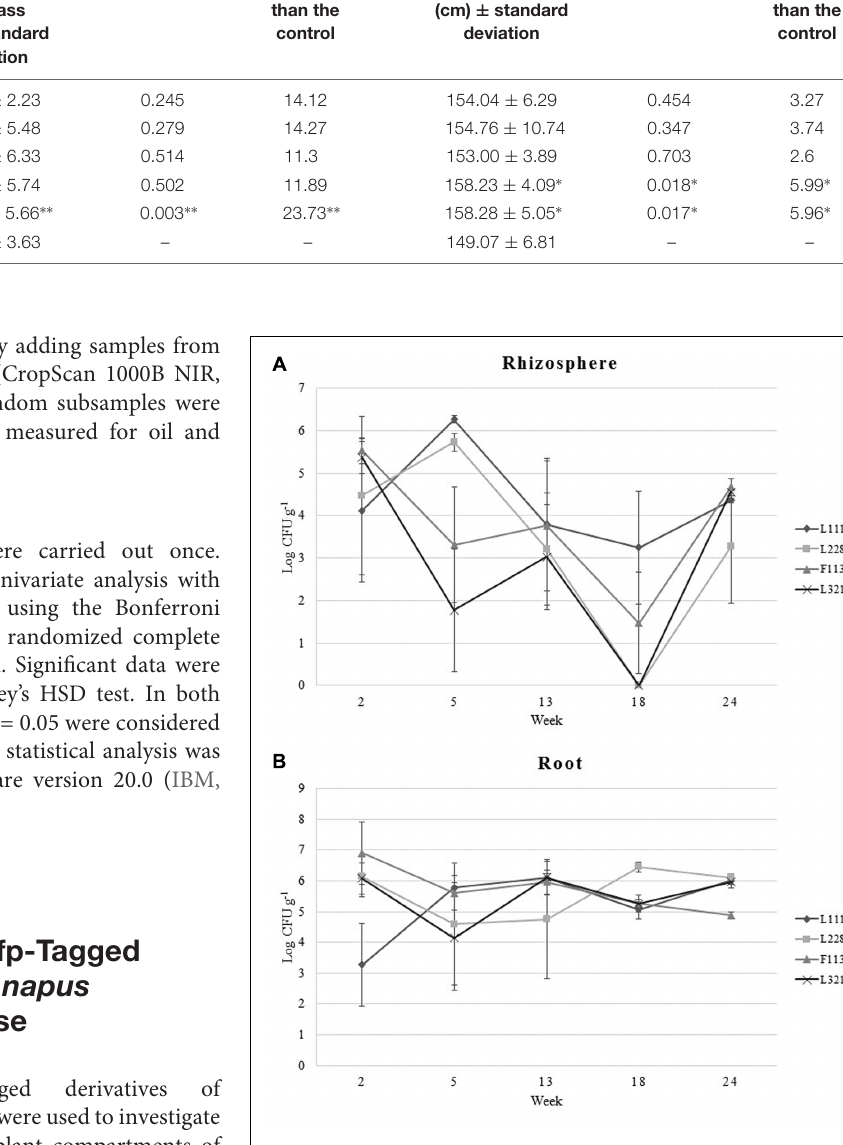
FIGURE 1 | Bacterial colonization of Brassica napus by PGP Pseudomonas and a bacterial consortium during a 24-week greenhouse trial. (A) Bacterial colonization levels of plant rhizosphere. (B) Colonization of plant root samples. Data represent the average number of CFUs at each sample time. Error bars represent standard error ( ±